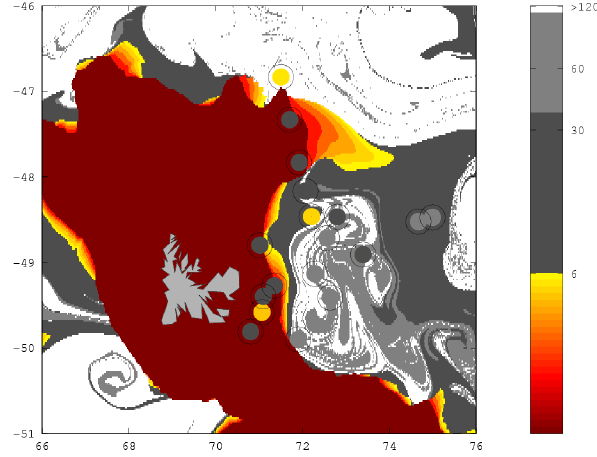
Figure 10. Ages of surface waters (in days) derived from an al- timetry Lagrangian-based model. In situ ages derived from radium isotopes are represented by circles. The color bar indicates the time elapsed since the water body left the 2000m